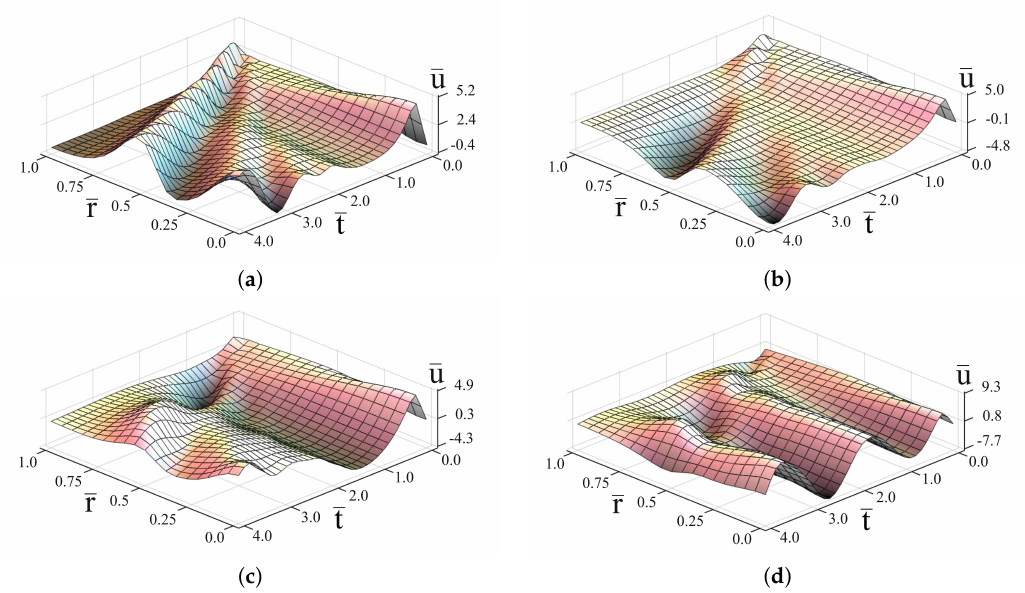
Figure 4. Evolution of the solution for the problems (12)–(15) with increasing the frequency ¯ ω in the sub-wave case. The results of computer simulation of the formula (27) for the parameters ¯ b = 1, α = 1.75 and different values of ¯ ω : ¯ ω = 0.0—( a ); ¯ ω = 1.0—( b ); ¯ ω = 2.0—( c ); ¯ ω = 4.0—( d